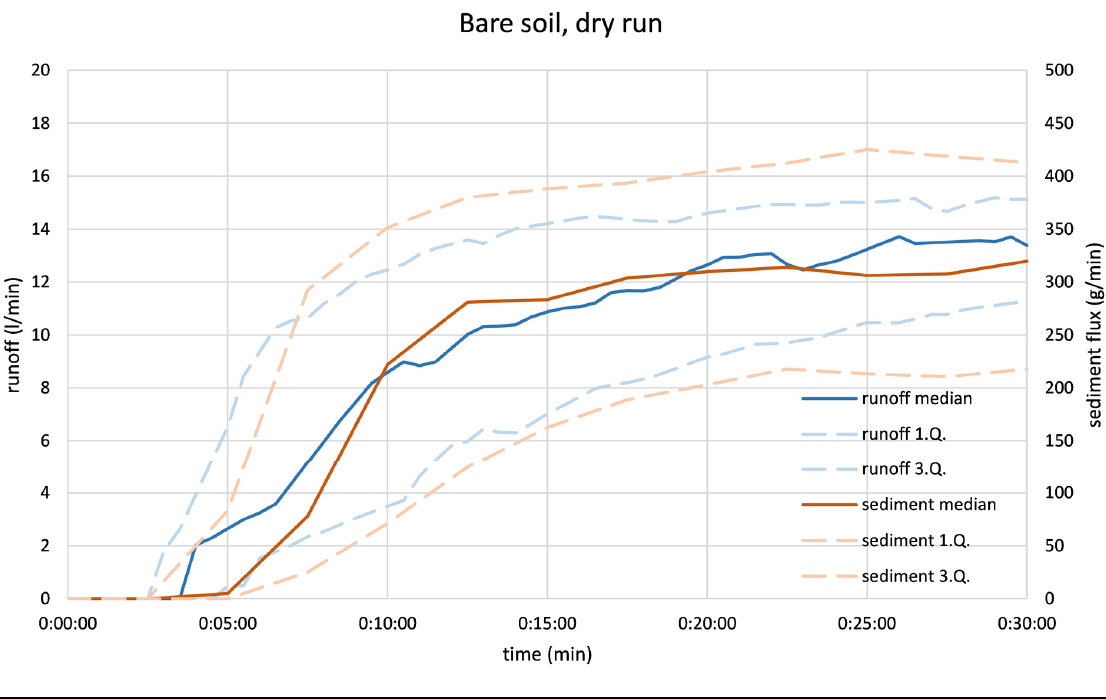
Figure 3. Simulation run under dry soil